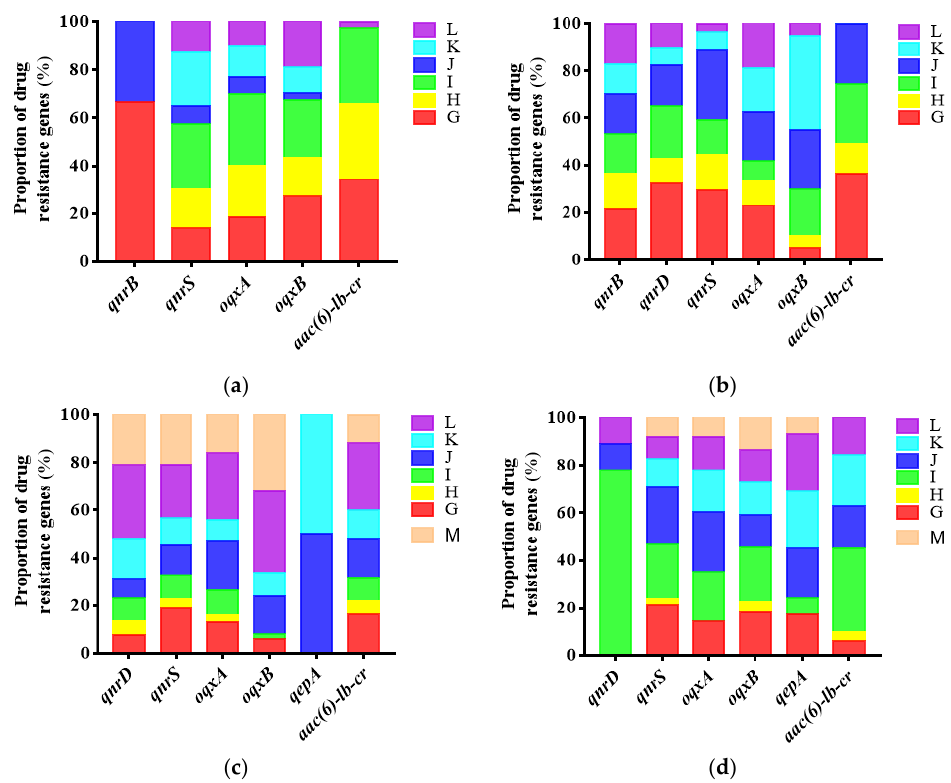
Figure 6. The proportion of the detection rate of antibiotic-resistant genes in E. coli from environmental sources in different cycles. ( a – d ) respectively represent the first cycle to the fourth cycle. M: Biological media; G: Feed; H: Water source; I: Fecal water; J: Dust; K: Feces; l: Tools.